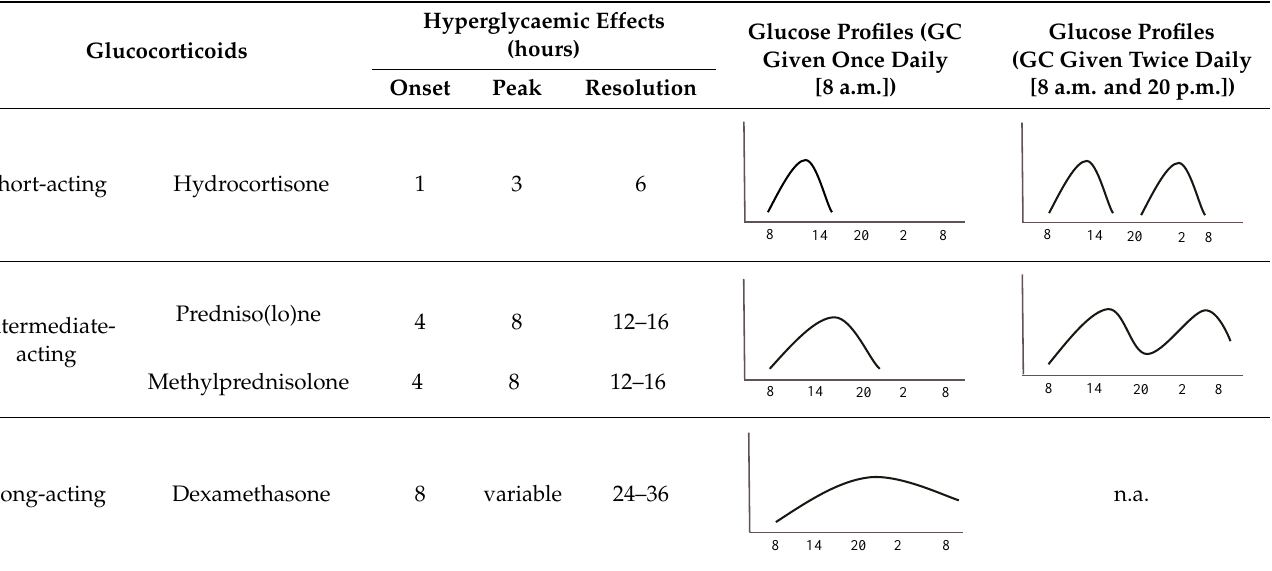
Table 1. Different corticosteroids and their equivalent doses, steroidal kinetics and potential to trigger hyperglycaemia. Glucocorticoids